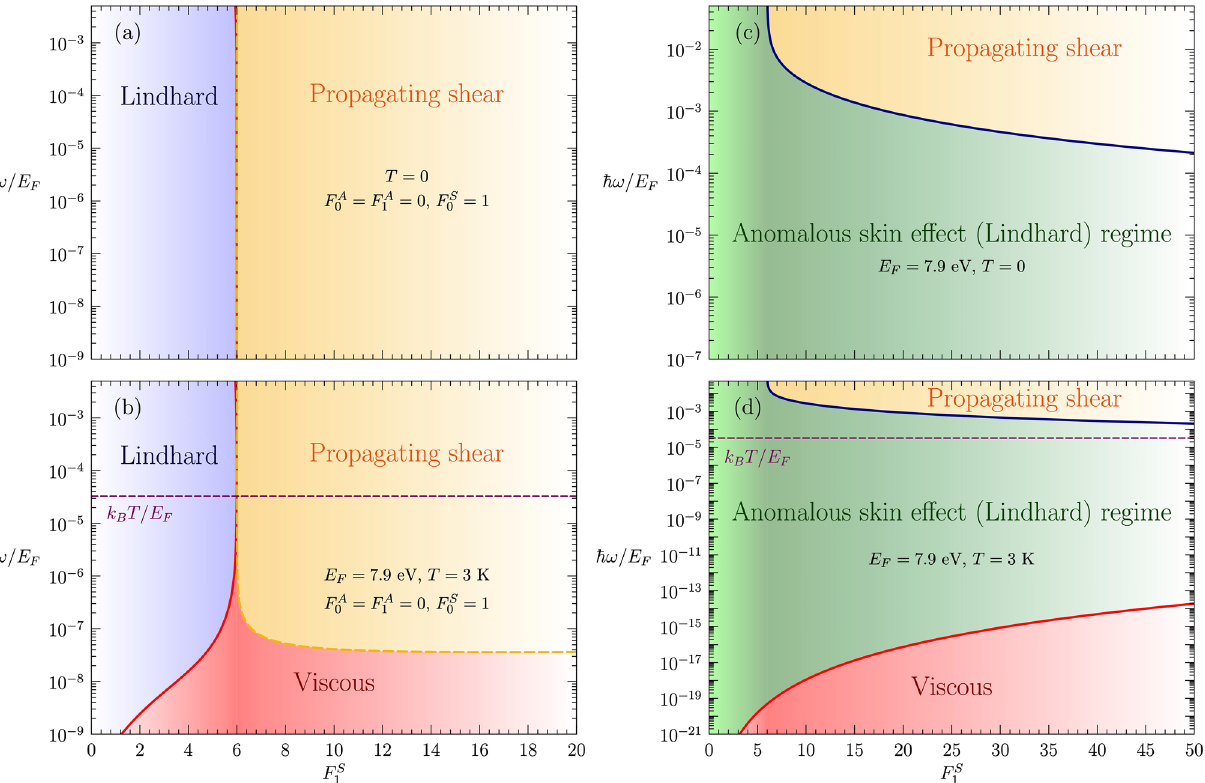
Figure 3. Diagram of the shear response in neutral and charged Fermi liquids. ( a ) Shear-response diagram of the zero-temperature neutral Fermi liquid as a function of excitation energy (cid:31) ω/ E F and F S 1 , calculated from ω( q )/ q , and using the Fermi-liquid collision time τ c . Notice that the the transverse-sound velocity v s (ω) = 0 the collision time τ zero-temperature phase diagram is valid at any electron density n , since at T c becomes = 6 separates the Lindhard regime, where the Lindhard a universal function of (cid:31) ω/ E F . The threshold F S 1 = continuum dominates the response and the transverse susceptibility has no pole, and the propagating shear 3 K and E 7.6 regime, where transverse sound propagates. ( b ) Neutral shear-response diagram at T F = = 3 ). For F S 10 23 cm 6 , the red solid line marks the crossover between the viscous eV (electron density n − 1 < = v ∗ regime of hydrodynamic damped transverse sound and the Lindhard regime. For F S 1 > 6 , the condition ω F = Re q (dashed golden line) identifies the crossover between viscous and propagating shear regimes. ( c ) Long- 0 and E 7.6 eV, calculated from the wavelength shear-response diagram of the charged Fermi liquid at T F = = dispersion relation of the shear-polariton and the Fermi-liquid optical conductivity in Kubo formalism. The shear-polariton emerges from the continuum at the solid blue line. Deep inside the continuum, the response is dominated by the Lindhard continuum and yields the phenomenology of anomalous skin effect. ( d ) Charged 3 K and E 7.6 eV. The red line shows the condition δ 0 l c , with δ 0 the EM shear-response diagram at T F = = = skin depth in anomalous regime and l c the collisional mean free path, which indicates the crossover between the anomalous skin effect and viscous regimes, with the latter implying hydrodynamic